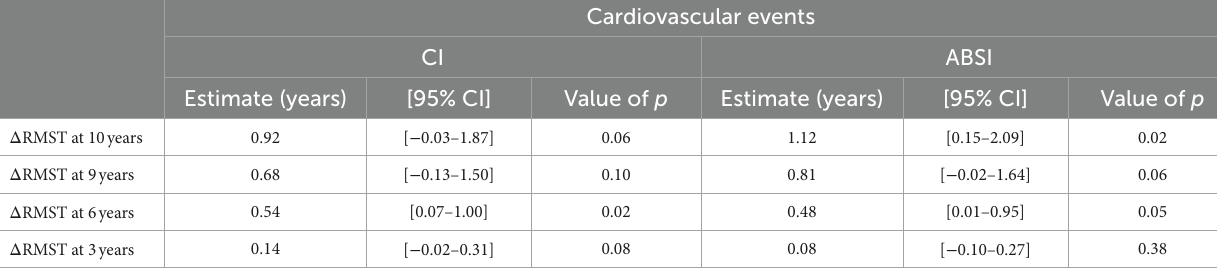
TABLE 5 The age-weighted restricted mean survival time (RMST) analysis adjust for gender, DM, CVD, and total cholesterol.